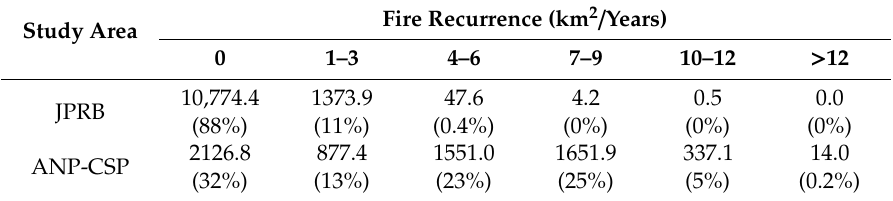
Table 3. Area burned in square kilometer (km²) by fire recurrence class in the period 2001–2016. Study Area